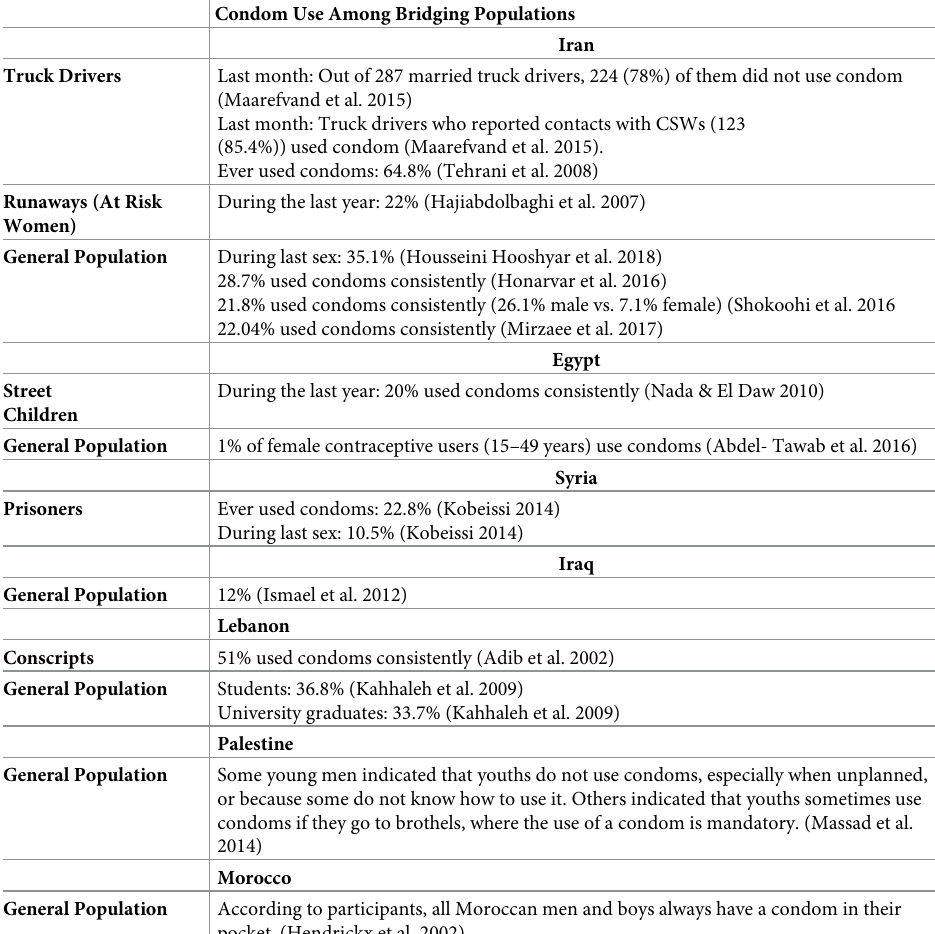
Table 5. Condom use among bridging populations in the MENA